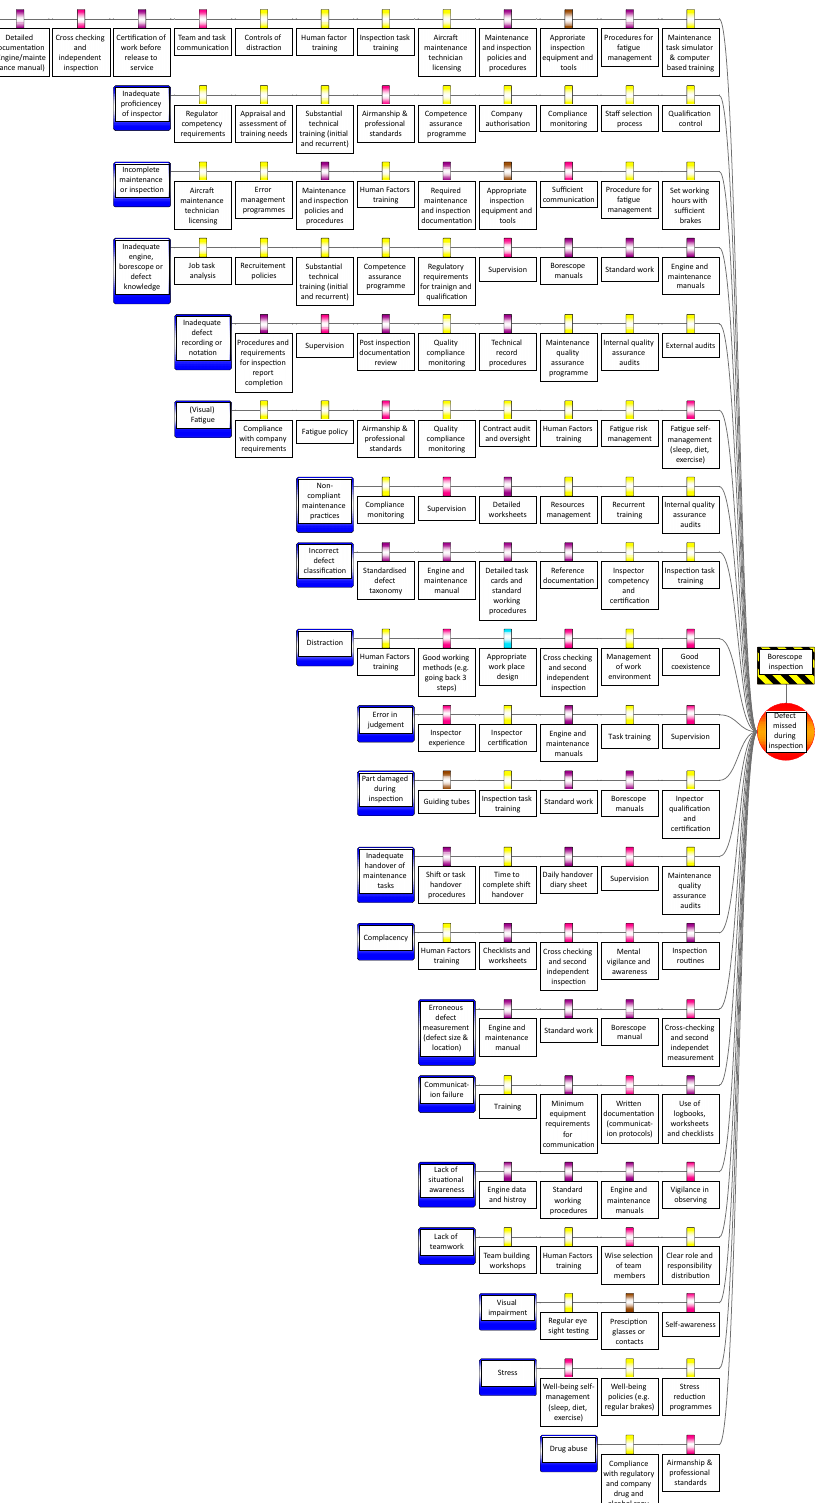
Figure A4. Man-related threat paths with barriers.